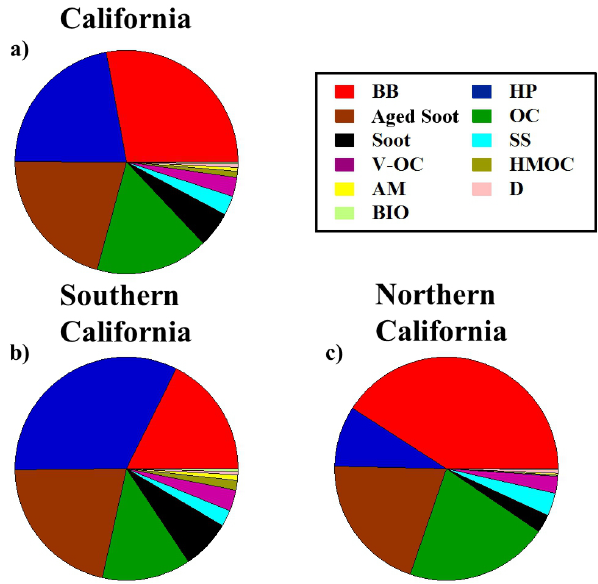
Fig. 2. Number fractions of A-ATOFMS particle sources, deter- mined by the most dominant ions in A-ATOFMS mass spectra, for California (a) , southern California (b) , and northern California (c)